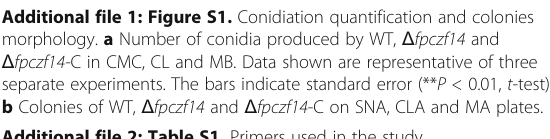
Additional file 1: Figure S1. Conidiation quantification and colonies morphology. a Number of conidia produced by WT, Δ fpczf14 and Δ fpczf14 -C in CMC, CL and MB. Data shown are representative of three separate experiments. The bars indicate standard error (** P < 0.01, t -test). b Colonies of WT, Δ fpczf14 and Δ fpczf14 -C on SNA, CLA and MA plates. Additional file 2: Table S1. Primers used in the